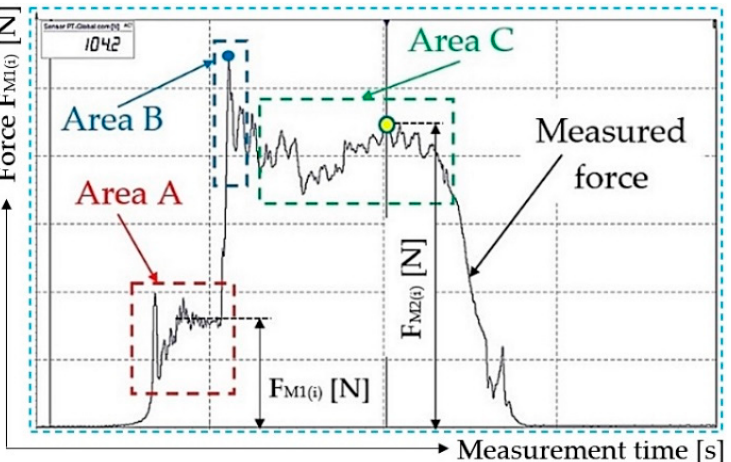
Figure 12. Tensile force measurement that defines the resistance of the scraper plough.